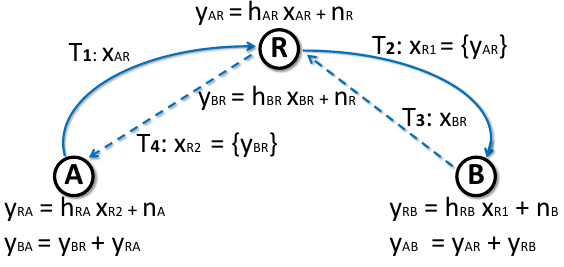
Figure 1: Traditional scheme for secret key genera- tion requires 4 time slots.